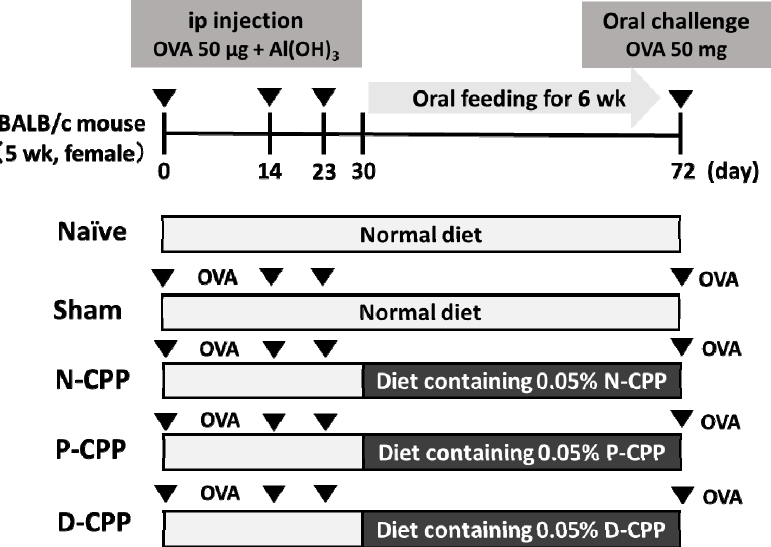
Figure 1. Scheme of in vivo experiment and systemic anaphylactic reactions post-oral challenge with ovalbumin (OVA). Female BALB/c mice were divided into five groups ( n = 6). Naïve group was not sensitized, not orally challenged, and fed a commercial mice diet; sham-treated group was sensitized with OVA, orally challenged with OVA, not treated, and fed a commercial diet; native CPP-III (N-CPP), phosphorylated CPP-III (P-CPP), and dephosphorylated CPP-III (D-CPP) were sensitized and orally challenged with OVA and then fed a homemade diet containing 0.05% of N-CPP, P-CPP, and D-CPP, respectively. BALB/c mice were sensitized with 50 μ g of OVA plus aluminum hydroxide Al(OH) 3 as an adjuvant. Sensitization was repeated 14 days after the initial sensitization. After 6 weeks, oral challenge with 50 mg/mL OVA in PBS was conducted.